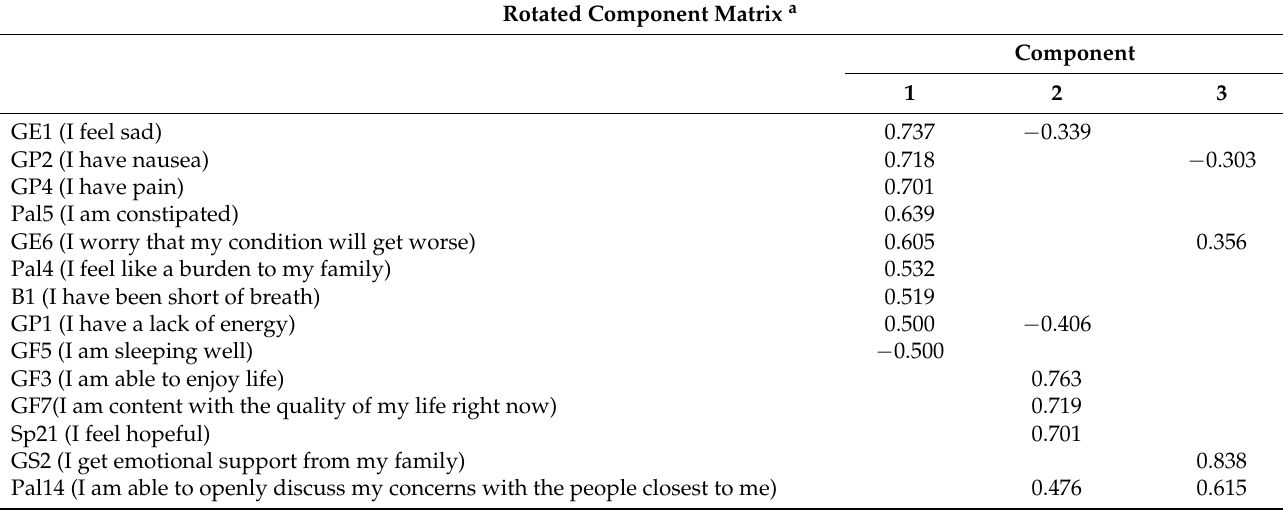
Table 3. Exploratory factor analysis for